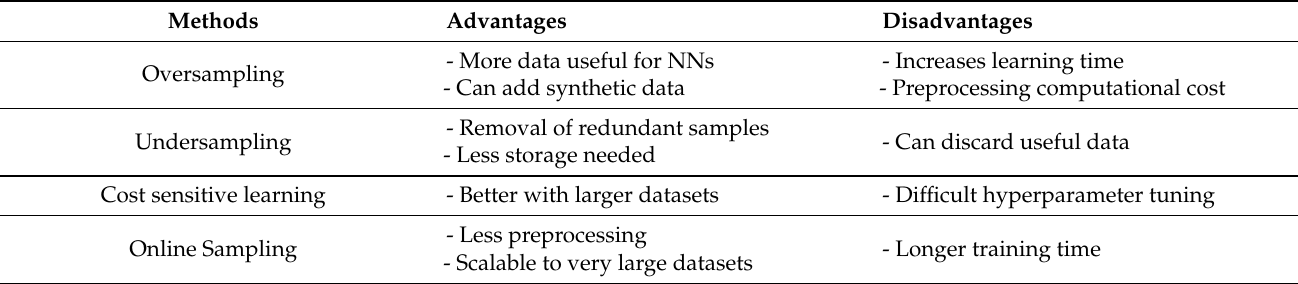
Table 1. Advantages and disadvantages of all the methods in